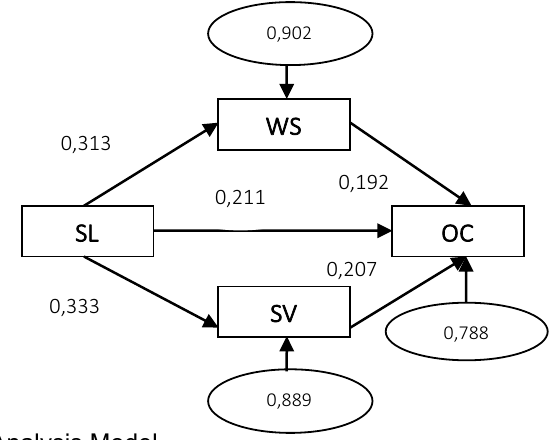
Figure 1: Path Analysis